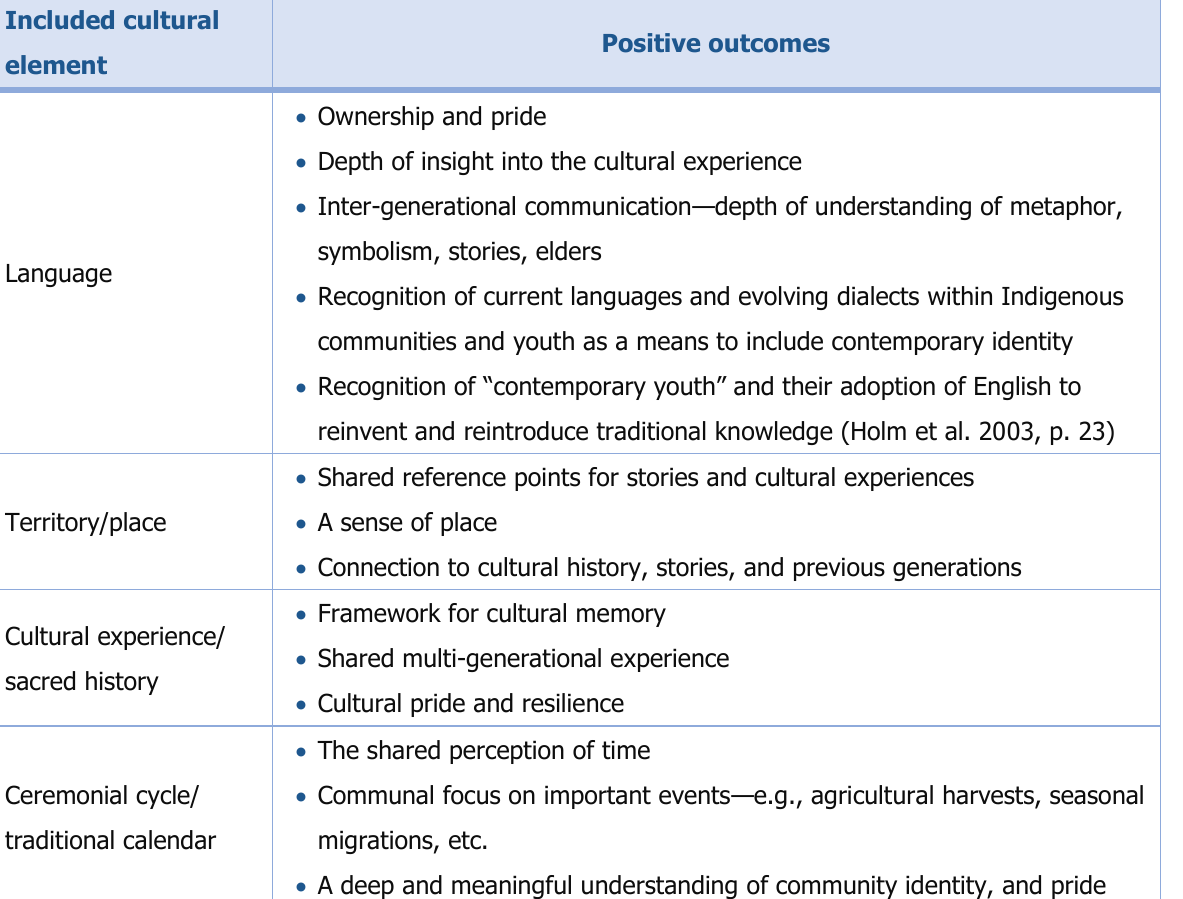
Table 2. Positive Outcomes From the Inclusion of the Peoplehood Model Elements Included